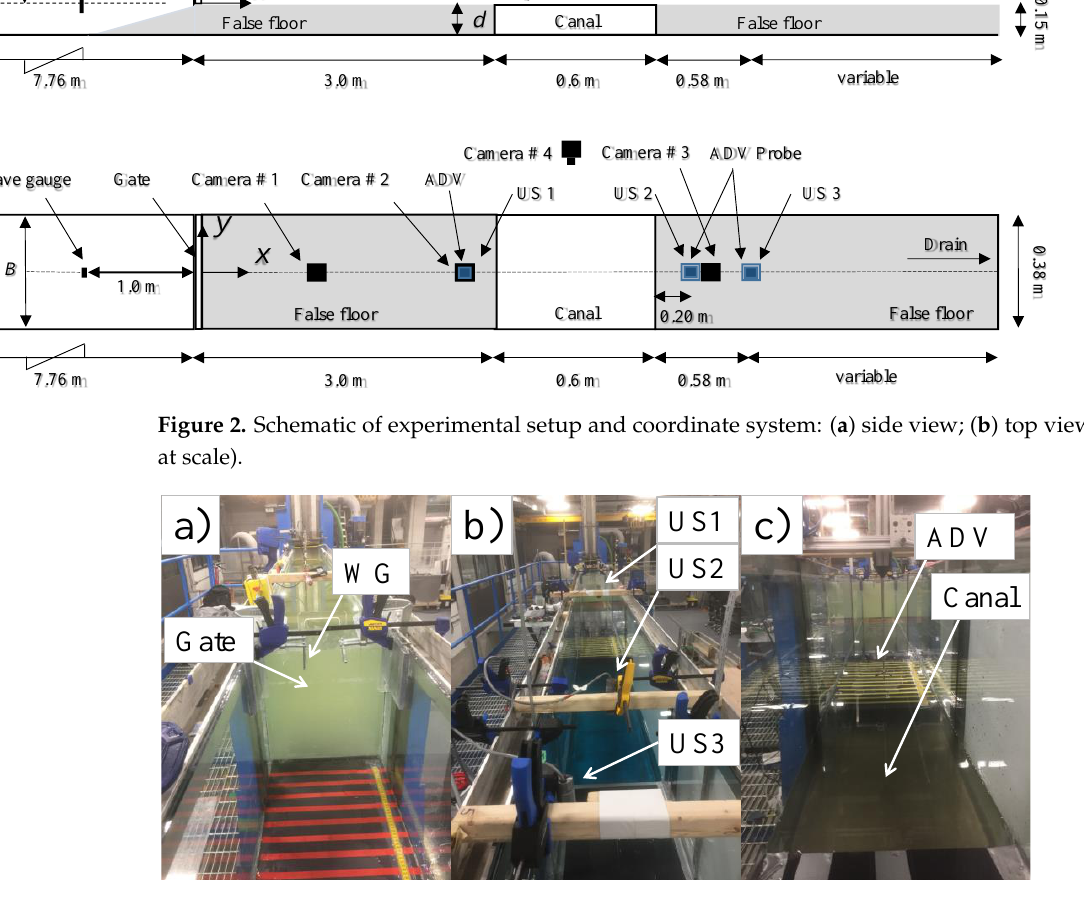
Figure 3. Laboratory experimental setup: ( a ) upstream view of the flume and the vertical gate; ( b ) positions of the ultrasonic depth sensors (US) in the flume; ( c ) upstream view of the canal and the ADV probe. Table 1. Parameters of the performed tests.